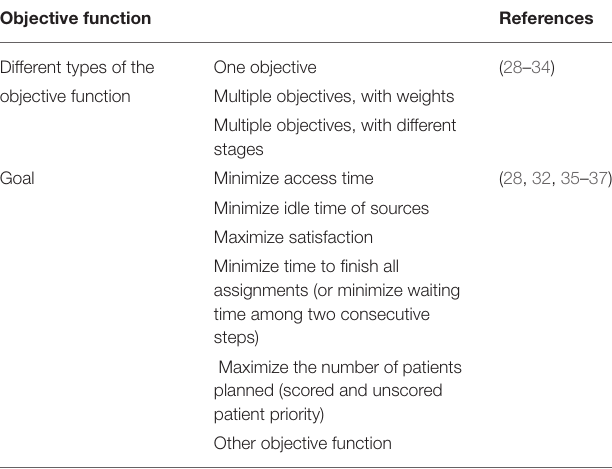
TABLE 3 | Taxonomy relies on the objective